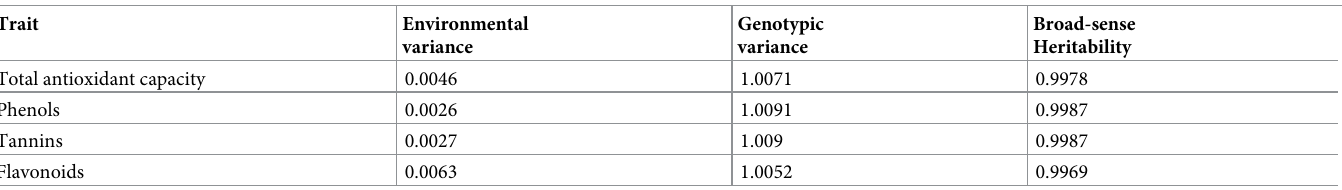
Table 1. Broad-sense heritability of the antioxidants measured in the sorghum